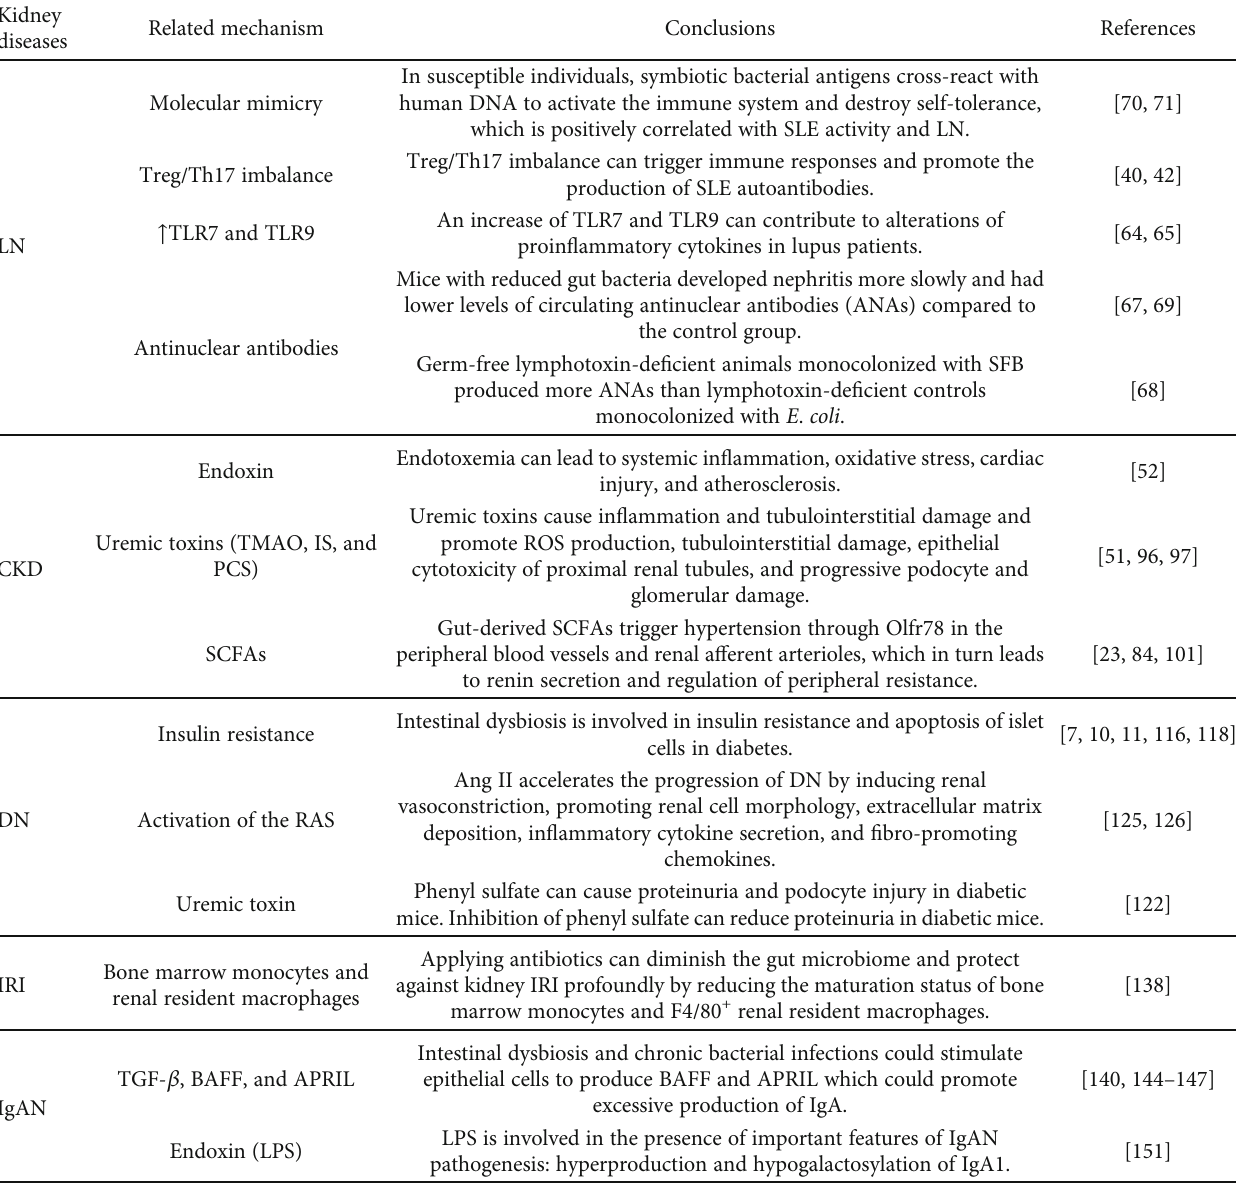
Table 1: The related mechanism in the relationship between gut microbiota and kidney